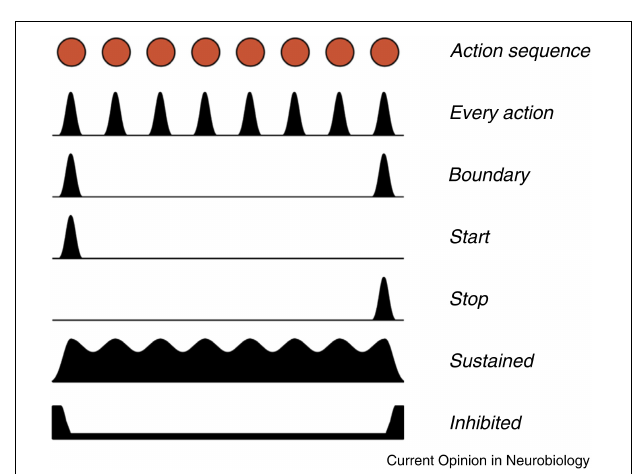
FIGURE 4 | Different patterns of signaling were observed in neurons in the basal ganglia during the execution of a learned action sequence with eight units. Based on recordings from the SNc, striatal projection neurons, and from basal ganglia output neurons, in mice. The red dots at the top represents a timeline of eight actions in an action sequence. The black surfaces represent the variations in firing in different populations of basal ganglia neurons. For example, one population signals for every action, while other neurons only signal at the start and the end of the sequence. Reprinted from Jin and Costa (2015) with